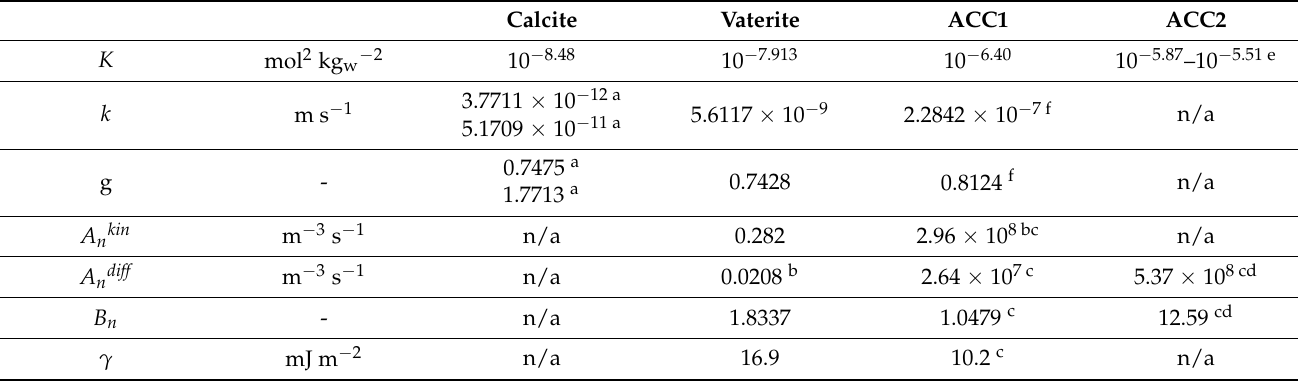
Table 4. Summary of parameters calculated for growth and nucleation Equations (2), (3), (9) and (10) for calcium carbonate polymorphs at 25 ◦